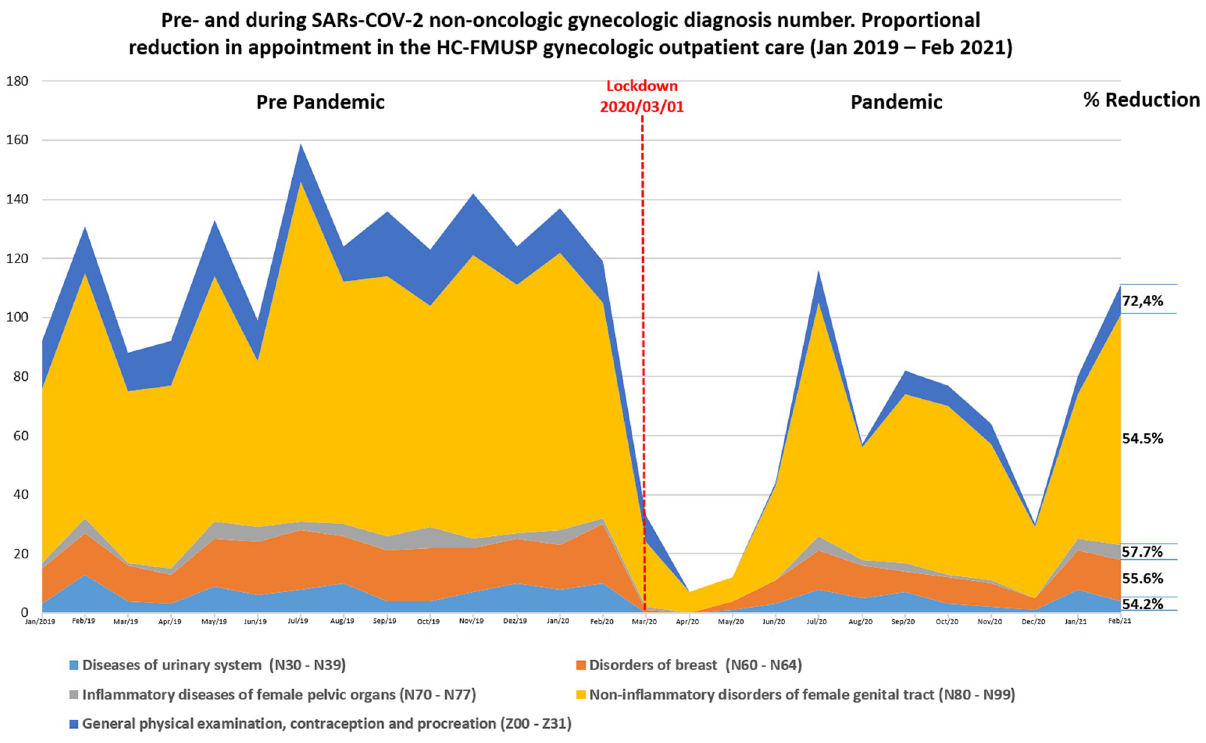
Fig 1. Non-oncologic diagnosis number in pre- and SARS-CoV-2 pandemic period. Proportional reduction in appointment in the HCFMUSP gynecologic outpatient care (Jan 2019 –Feb 2021). The widths of each color correspond to the total consultations of each diagnoses group per month.